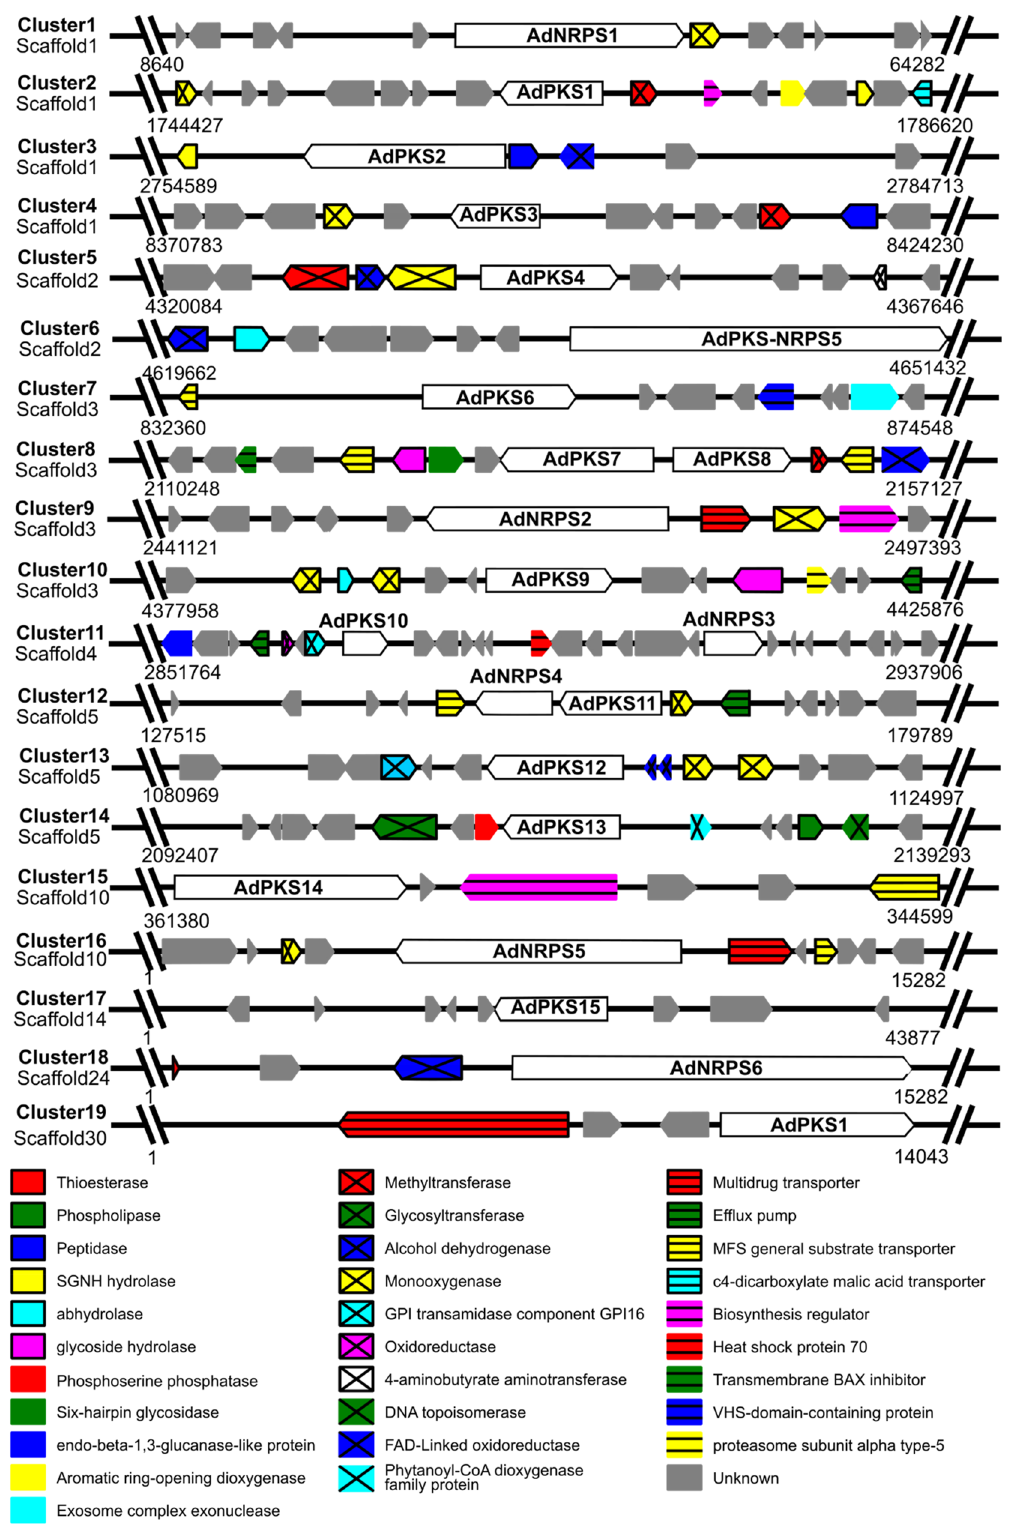
Figure 3. Alternaria dauci secondary metabolism cluster organization as predicted by antiSMASH and SMURF. BLASTP searches were performed to identify a potential function for each gene in the cluster (more details in Supplementary Table